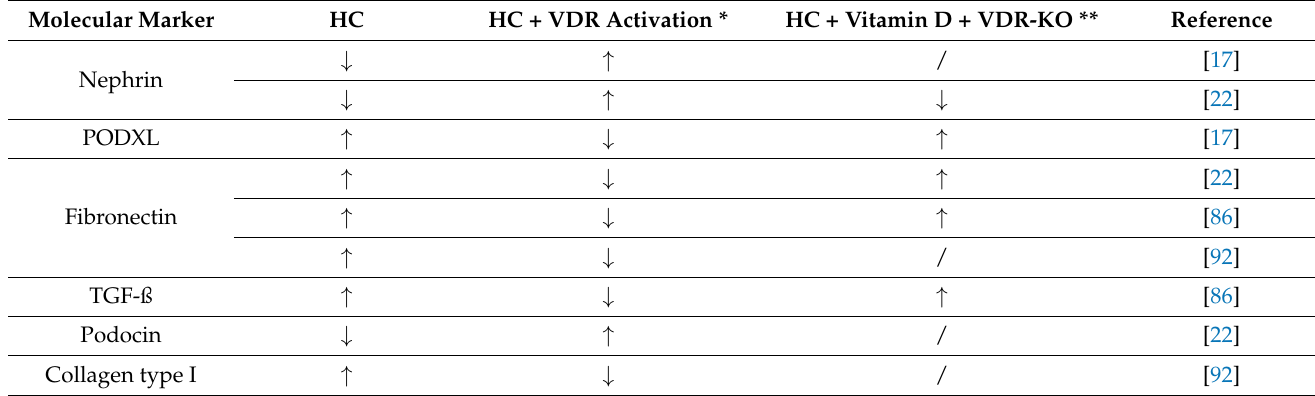
Table 1. Overview of possible molecular mechanisms of development of diabetic nephropathy in an- imals. HC: hyperglycemic conditions; VDR-KO: vitamin D receptor gene knock down; PODXL: podocalyxin; TGF-ß: transforming growth factor-ß; * Compared to HC; and ** Compared to HC + vitamin